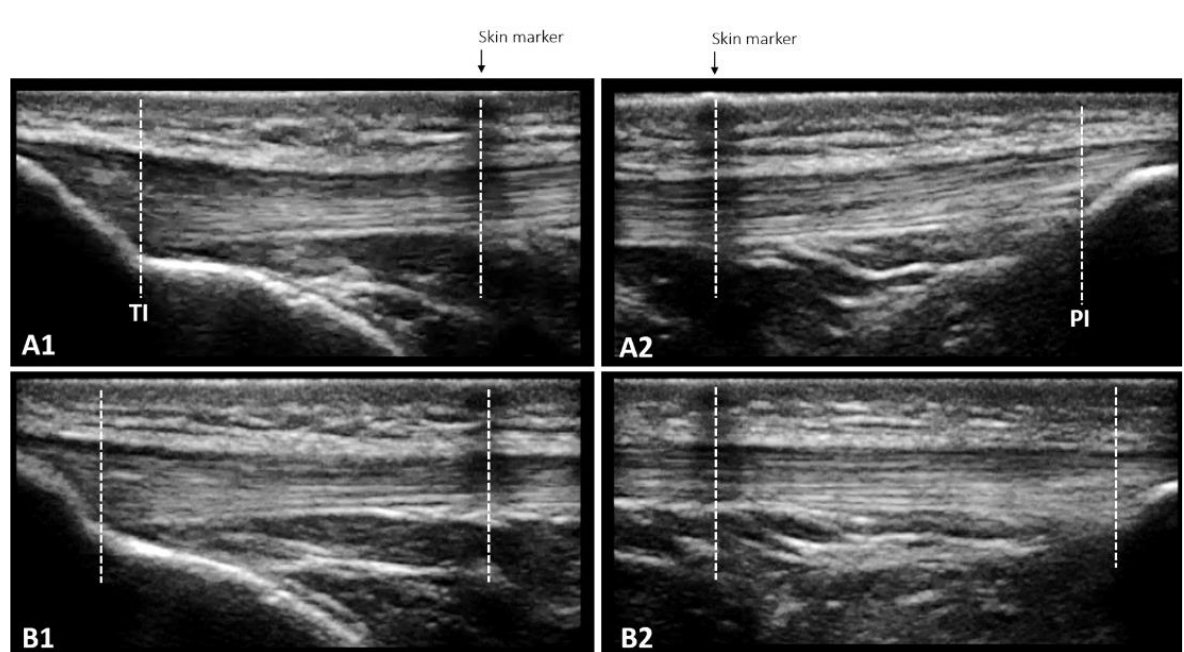
Figure 3. The overlapping images technique enables the measurement of patellar tendon length at rest ( A1 + A2 ) and in increments of 10% force up to maximum voluntary isometric contraction ( B1 + B2 ) when the entire length cannot be captured in a single frame due to the limited size of the ultrasound probe. A skin marker (adhesive tape) that creates a hypoechoic shadow is used to define the measurement bounds: the length from TI to the center of the skin marker in A1 and the length from the center of the skin marker to PI in A2 are added. The same procedure is repeated for each 10% increase in force, leading to B1 and B2.